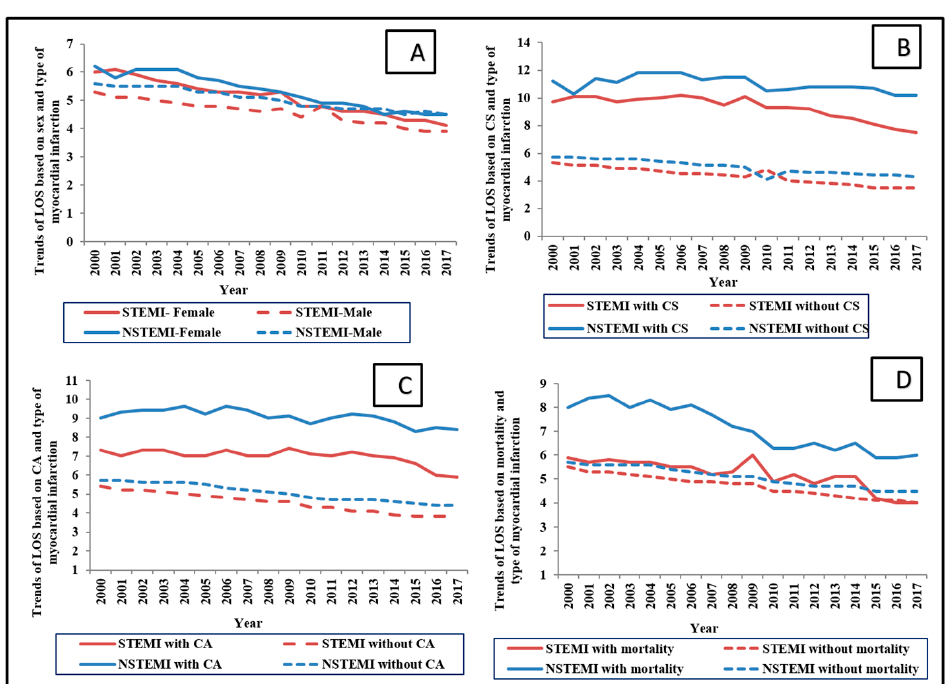
Figure 3. Temporal trends for LOS in AMI based on clinical and co-morbid conditions. Legend: A: Temporal trends LOS based on sex ( A ), presence of CS ( B ), CA ( C ), and mortality ( D ), stratified by type of AMI ( p < 0.001 for trend over time for all). Abbreviations: AMI: acute myocardial infarction; CA: cardiac arrest; CS: cardiogenic shock; NSTEMI: non-ST-segment elevation myocardial infarction; STEMI: ST-segment elevation myocardial infarction.